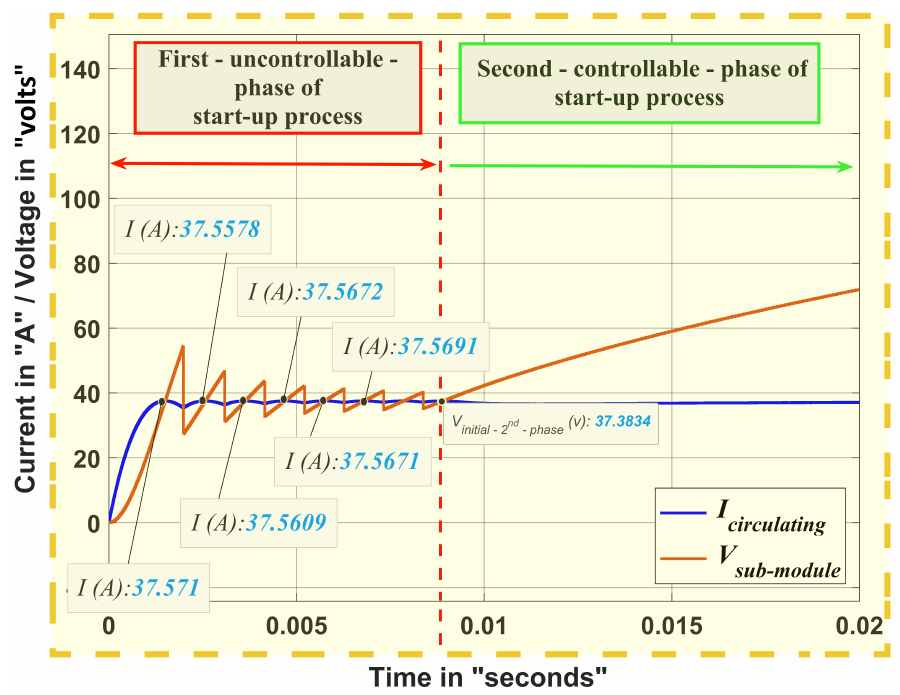
Figure 6. The first (uncontrollable) start-up phase of the proposed